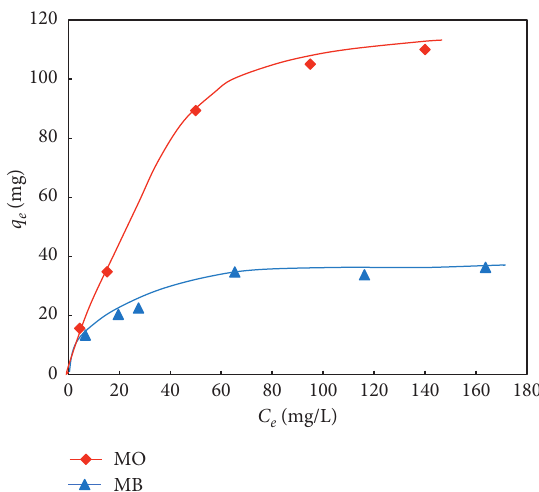
Figure 5: Langmuir adsorption isotherms of MO and MB adsorption onto UiO-66-NO